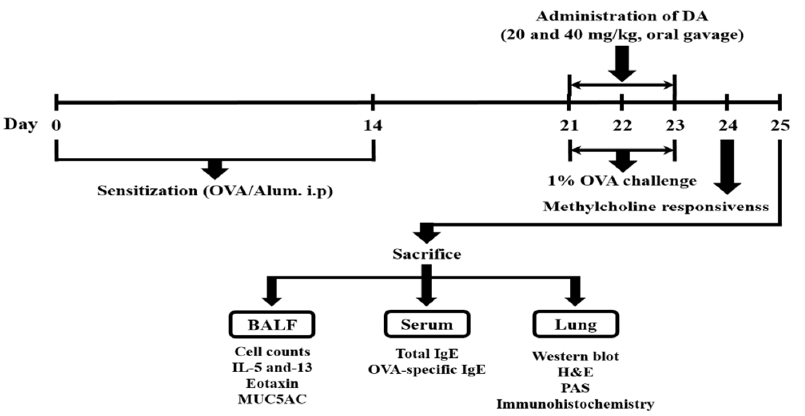
Figure 9. Experimental